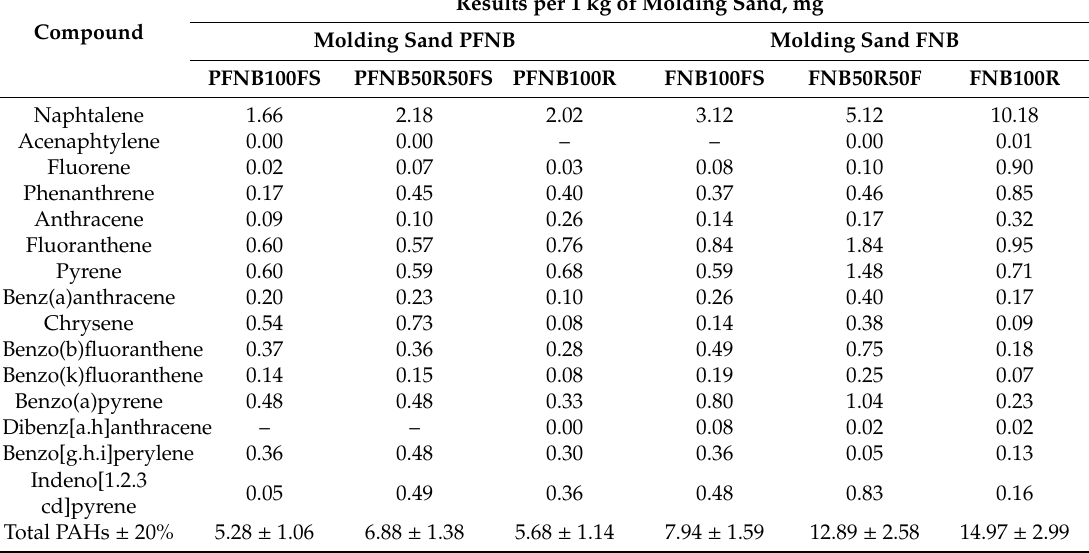
Table 6. Concentration of BTEX formed during thermal decomposition of molding sand (FNB and PFNB) with reclaimed sands [32,33].